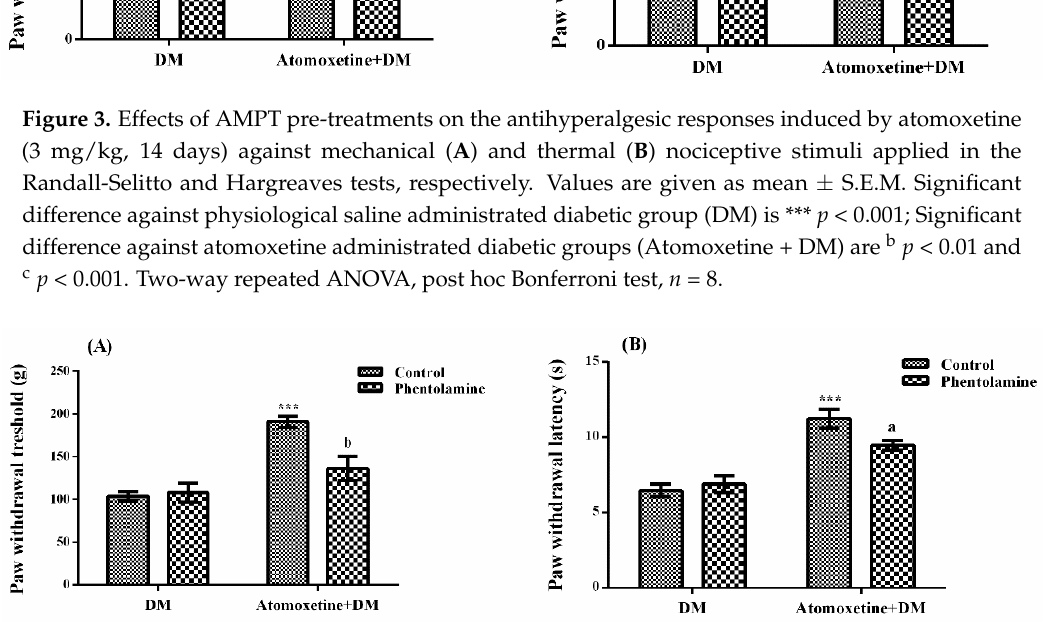
Figure 3. Effects of AMPT pre-treatments on the antihyperalgesic responses induced by atomoxetine (3 mg/kg, 14 days) against mechanical ( A ) and thermal ( B ) nociceptive stimuli applied in the Randall- Selitto and Hargreaves tests, respectively. Values are given as mean ± S.E.M. Significant difference against physiological saline administrated diabetic group (DM) is *** p < 0.001; Significant difference against atomoxetine administrated diabetic groups (Atomoxetine + DM) are b p < 0.01 and c p < 0.001. Two-way repeated ANOVA, post hoc Bonferroni test, n = 8.